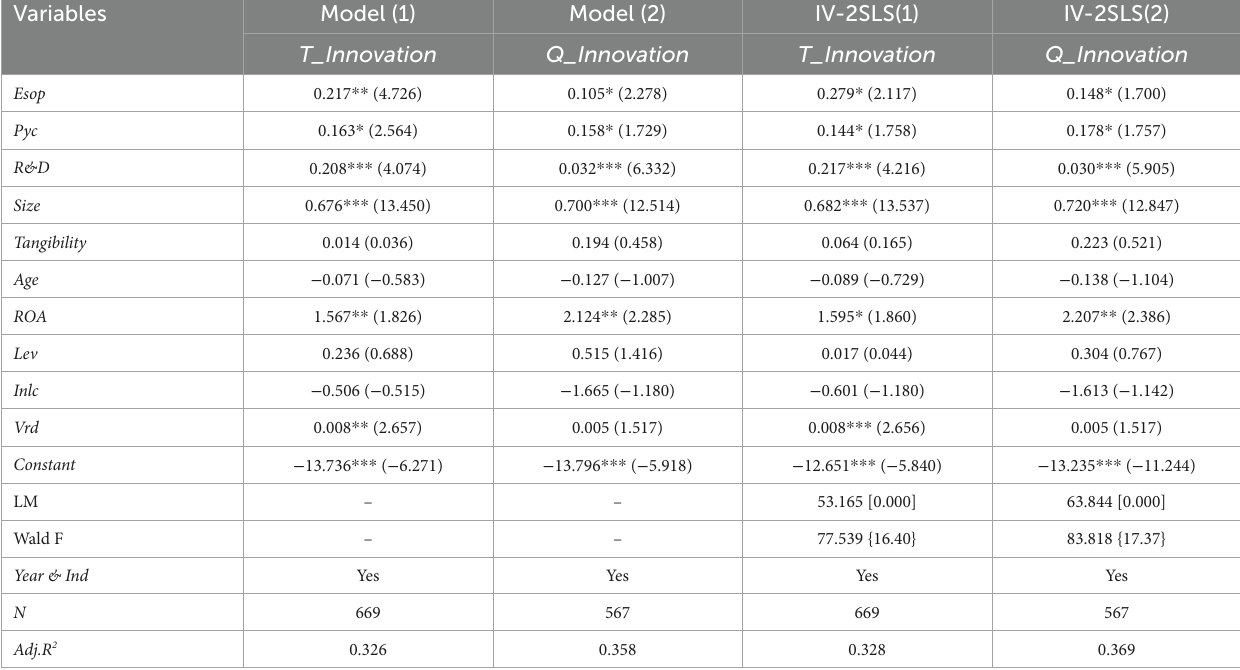
TABLE 5 Senior executives’ psychological capital, employee equity incentive, and enterprise